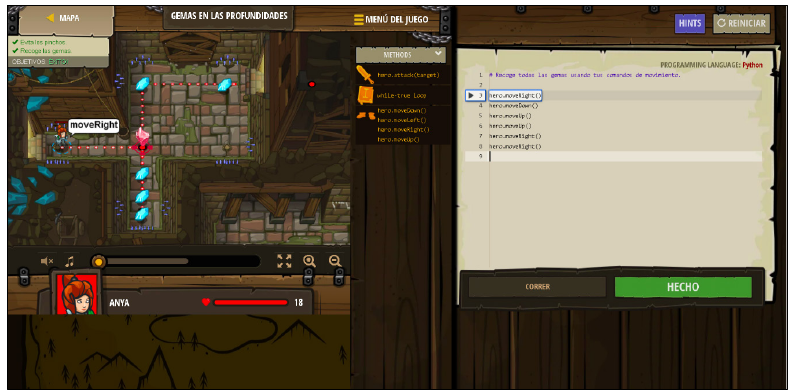
Fig. 1. Interface with the Code Combat game in